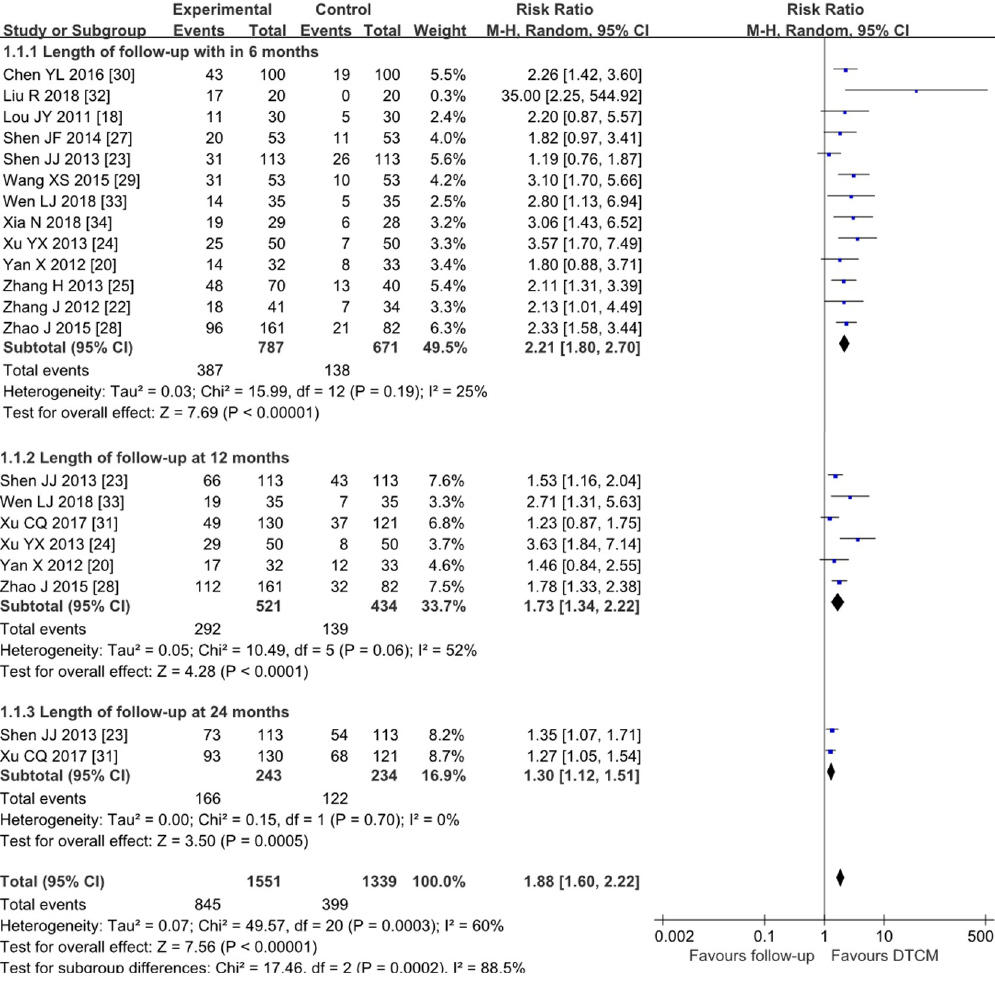
Fig 2. Analysis 1.1 Forest plot of comparison: DTCM treatment alone compared with follow-up. Outcome 1.1: Rate of hr- HPV clearance.